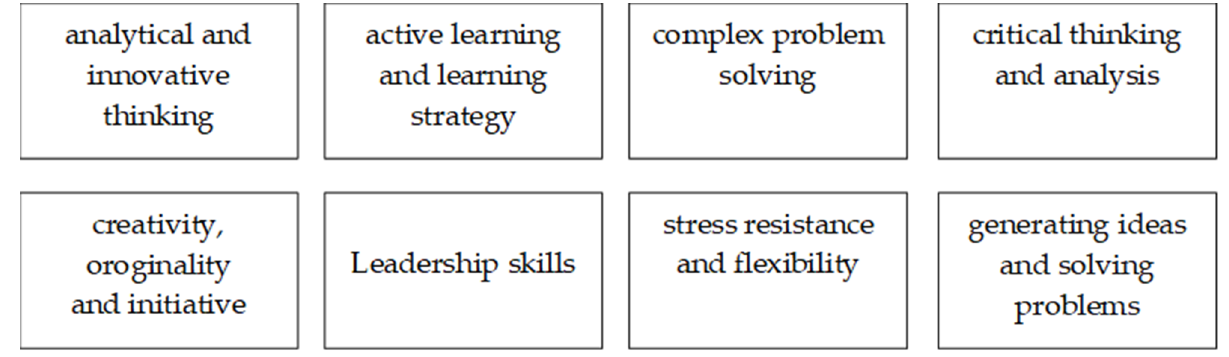
Figure 1. The soft skills that will be most in demand in 2025. Source: the authors based on data from (Doyle 2014; Kelly 2001; McLaughlin 1992; NCIHE 1997; Silaban and Silalahi 2020; Young and Chapman 2010).